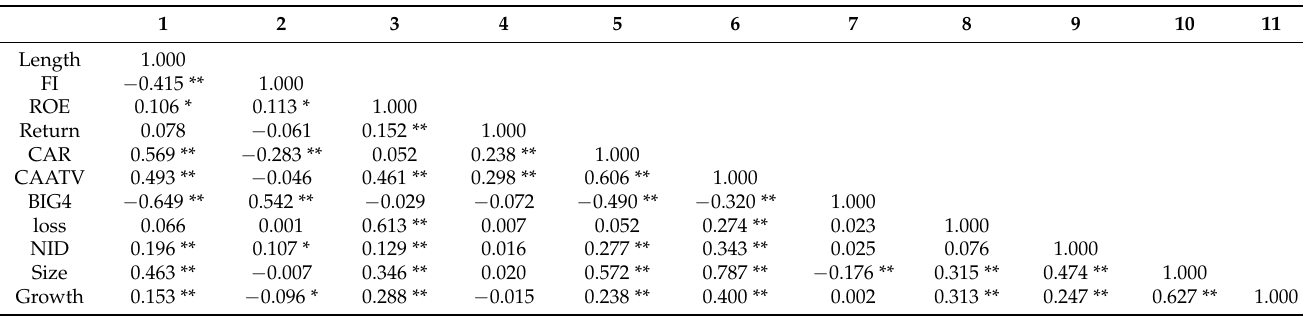
Table 2. Correlation